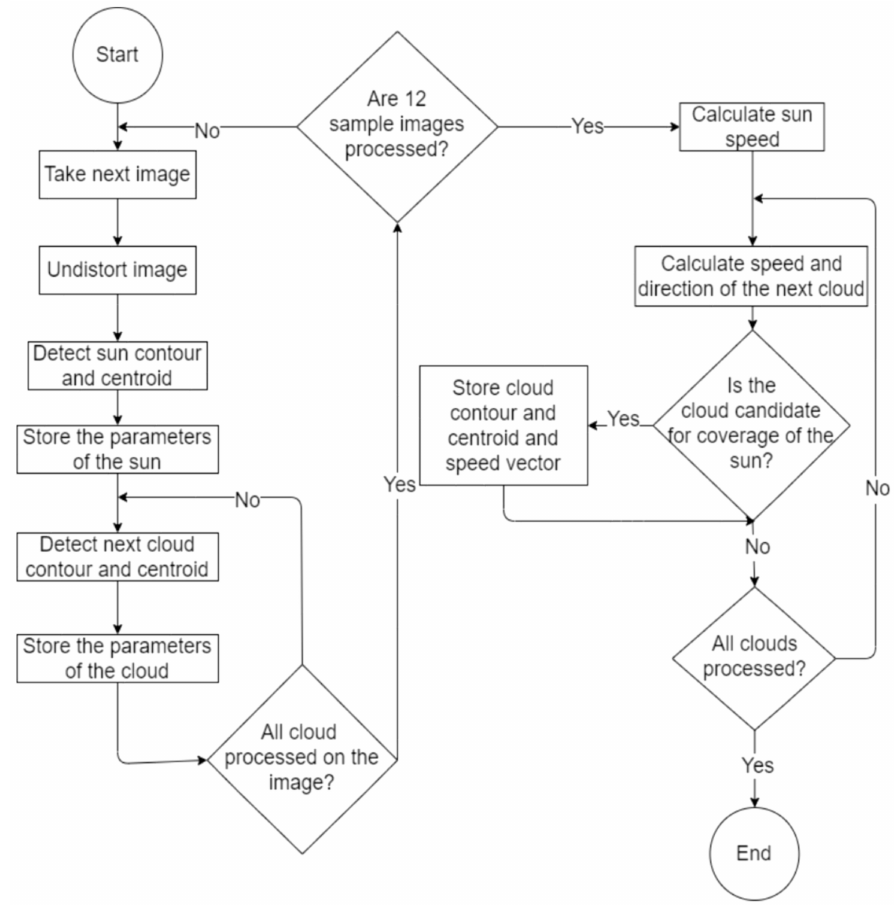
Figure 5. Image processing algorithm flow diagram.